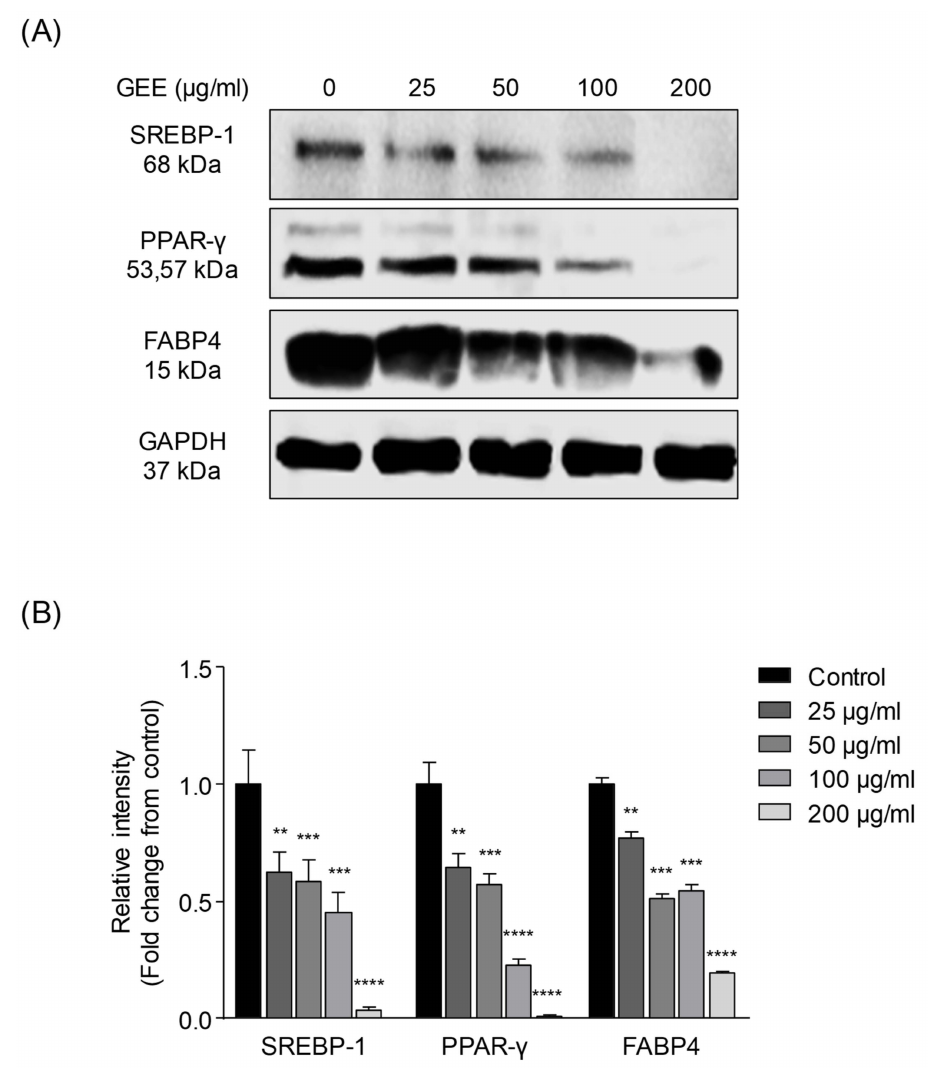
Figure 2. E ff ect of GEE on adipogenic protein expressions in 3T3-L1 cells: Western blot analyses of the sterol regulatory element binding protein-1 (SREBP-1), peroxisome proliferator activated receptor-gamma (PPAR- γ ), fatty acid binding protein4 (FABP4) were performed and adipogenic protein bands were quantified and presented as graphs. ( A ) The western blot bands of adipogenic proteins, ( B ) quantification of lipid content. Data are expressed as the mean ± SD, ( n = 3) in each group. Significant di ff erences were identified at ** p < 0.01, *** p < 0.001, and **** p < 0.0001, as compared to the control